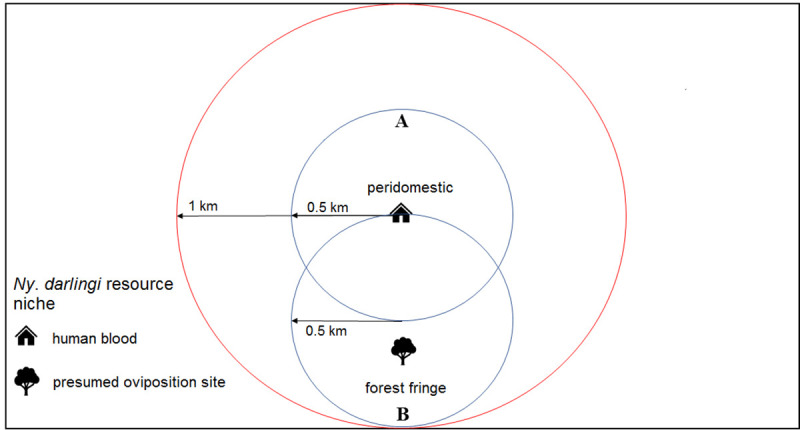
Study design scheme.Large circle (red) represents the sampling unit, and smaller circles (blue) the collection points. A: peridomestic habitat (HLC), and B: forest fringe habitat (ST).